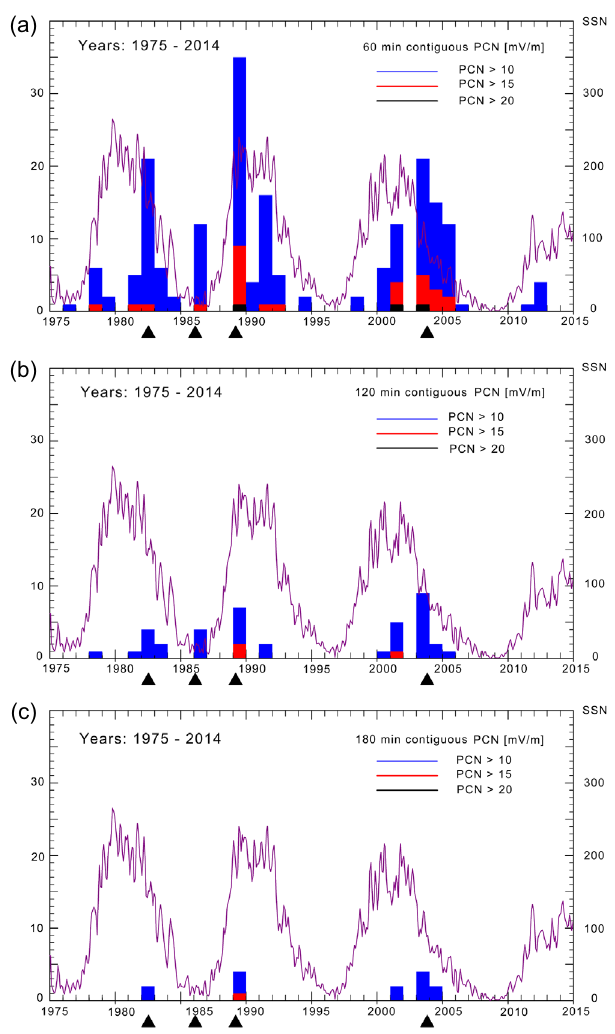
Fig. 10. (a) Yearly number of cases with PCN > 10, 15, and 20 mV/m, respectively, throughout 60 min. Sunspot numbers added. (b) Interval extended to 120 min. (c) Interval extended to 180